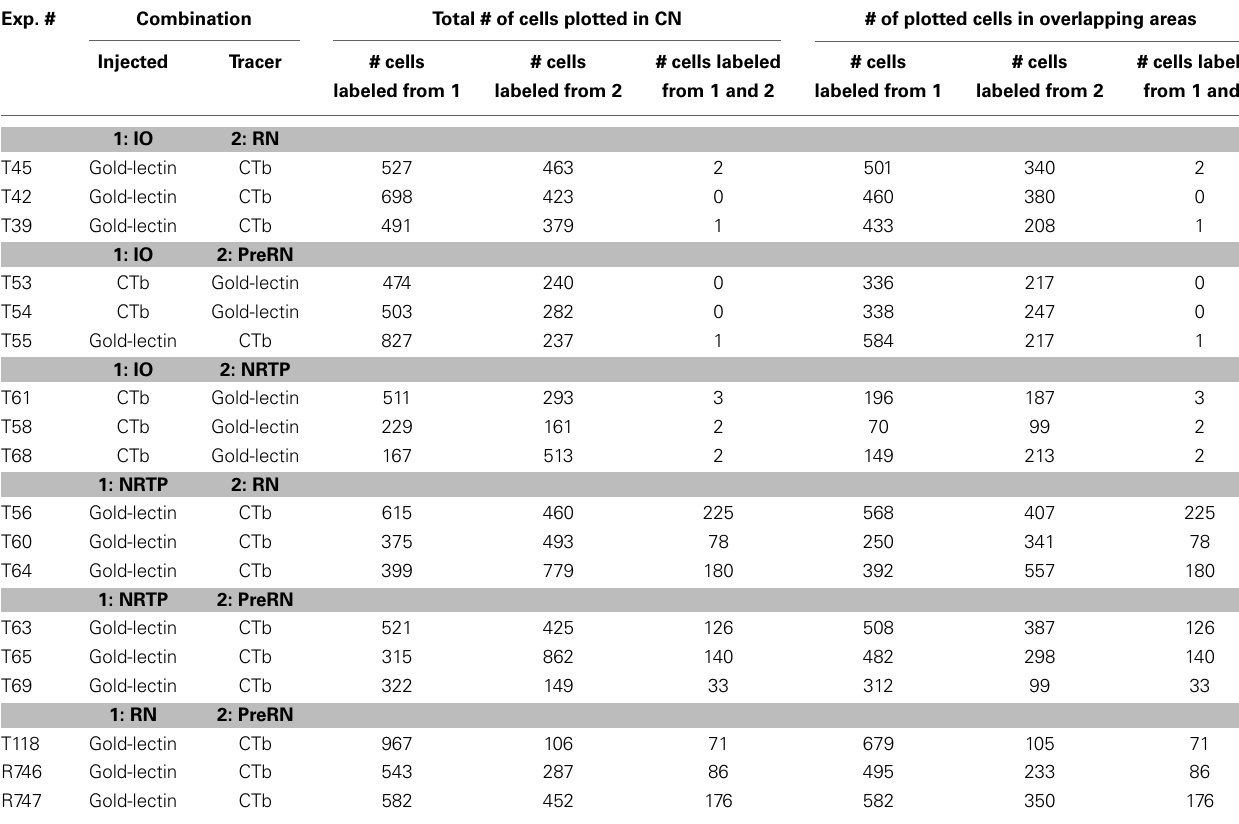
Table 1 | Numbers of single and double-labeled neurons plotted in 5 equidistant sections of the CN of all studied cases. Exp.